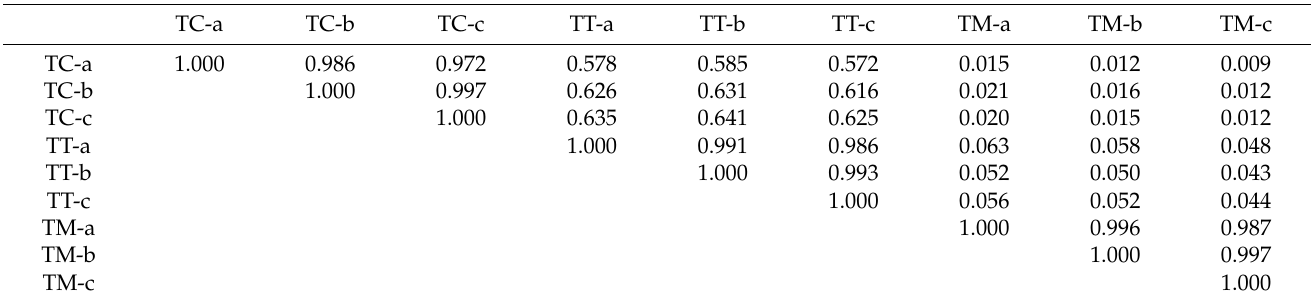
Table 4. Aroma similarity rates between the three species of Tilia at different flowering